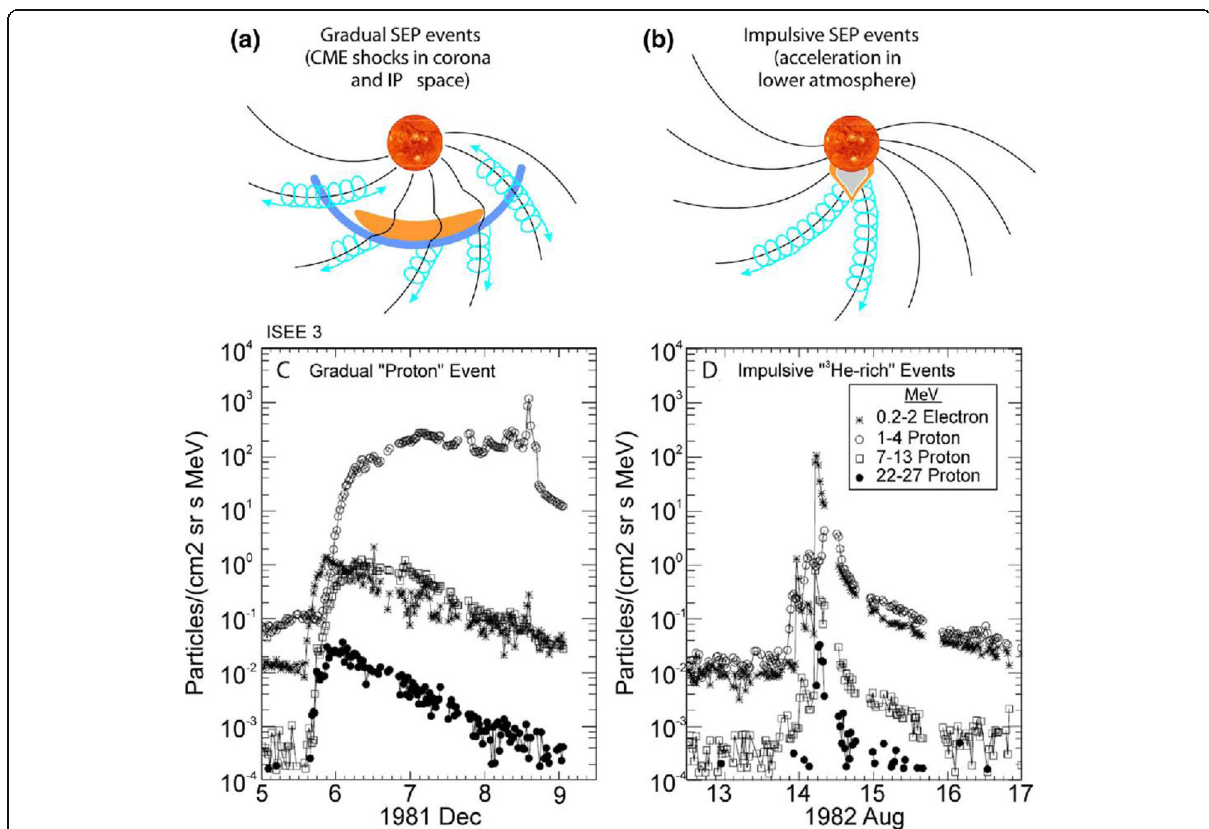
Fig. 19 The two-class paradigm for SEP events in which ( a ) gradual SEP events are produced as a result of diffusive acceleration by large-scale CME-driven coronal and interplanetary (IP) shock waves. The accelerated SEPs populate Interplanetary Magnetic Field (IMF) lines over a wide range of longitudes. ( b ) Impulsive SEP events are attributed to acceleration during magnetic reconnection in solar flares and observed when the observer is magnetically connected to the flare site. Intensity-time profiles of electrons and protons in ( c ) gradual and ( d ) impulsive SEP events. (Reproduced from Desai and Giacalone 2016, after Reames